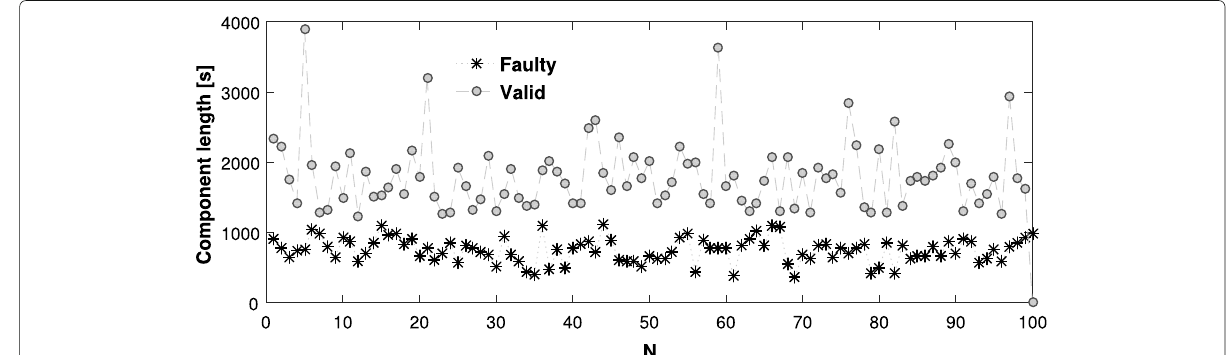
Fig. 11 The longest component length L max ( n ) in the spectrogram of faulty and valid electrodes for simulated signals